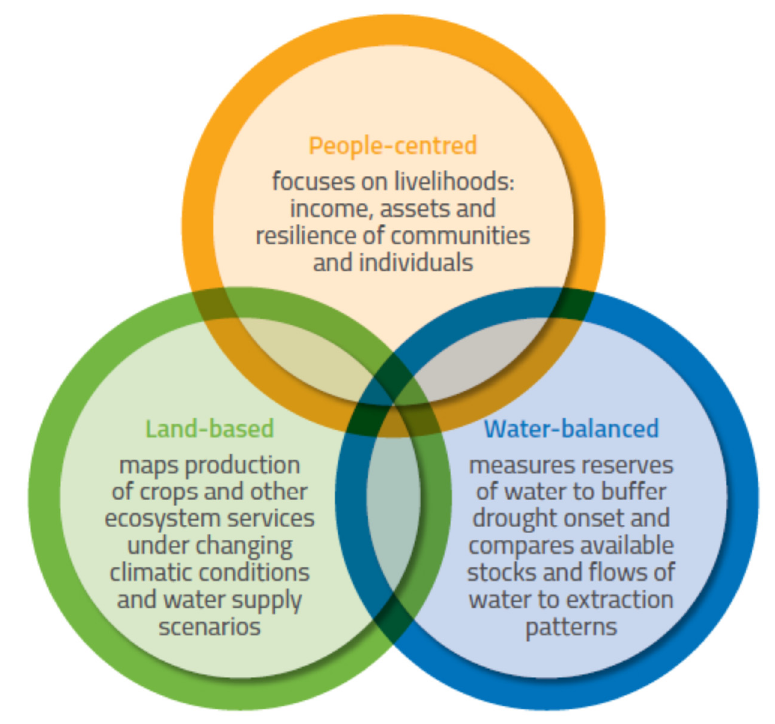
Figure 1. Three approaches to assessing three dimensions of vulnerability at the local level (source: [10]).